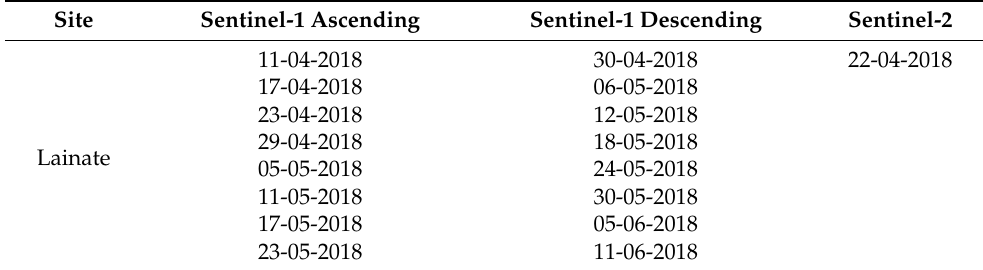
Figure 9. Lainate (north Italy) 13 km × 11 km test site. ( a ) Sentinel-2 RGB image. ( b ) FCM classifica- tion results. The color scale quantifies the level of membership to the urban class. Note that the value is continoues in the range (0,1) where red: urban, yellow: non-urban. Table 1. Remote sensing data used for the Lainate test